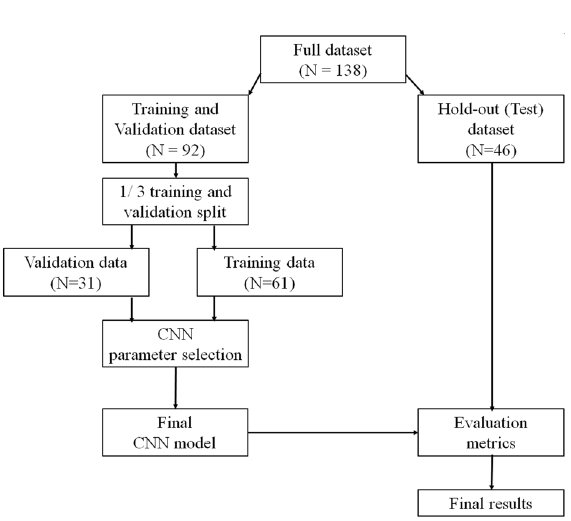
Figure 2. The 2D CNN architecture used in this study. The input polar map is a 256 × 256 RGB image. Each 2D convolutional layer contains a 3 × 3 kernel with stride 2 × 2 and ReLU as activation function. Filter sizes are increased gradually from 12, 16, 32 to 64. Each convolutional layer is followed by a max pooling layer with a window size of 2 × 2. Thus, the output of the last convolution and max-pooling layer is reduced to 1 × 1 × 64, which is given as an input to the flatten layer. The last layers contain a flatten layer of size 64 followed by two dense layer of sizes 512 and 128, using ReLU as activation function. The output layer is a dense layer with 1 output (0 or 1) with a sigmoid function. The input size of each convolutional layer and the flatten layer is given above each layer. For the fully connected layers, the output size is given. conv = 2D convolutional layer, flatten = flatten layer, fc = fully connected layer.